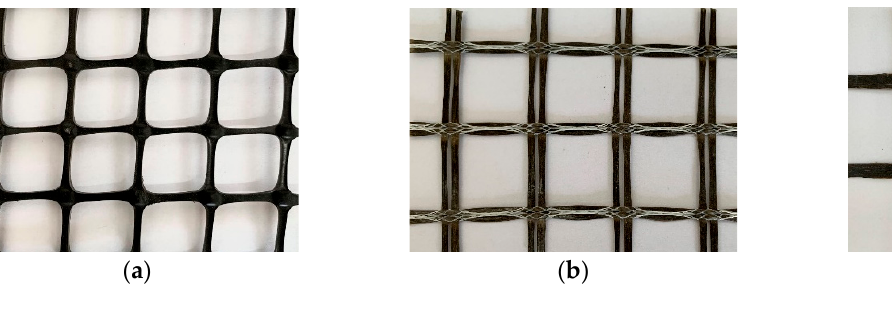
Figure 1. The specific shape of the textile ( a ) PP, ( b ) BFRP-F, ( c ) BFRP-T. Table 1. The details of textile types. Table 1. The details of textile